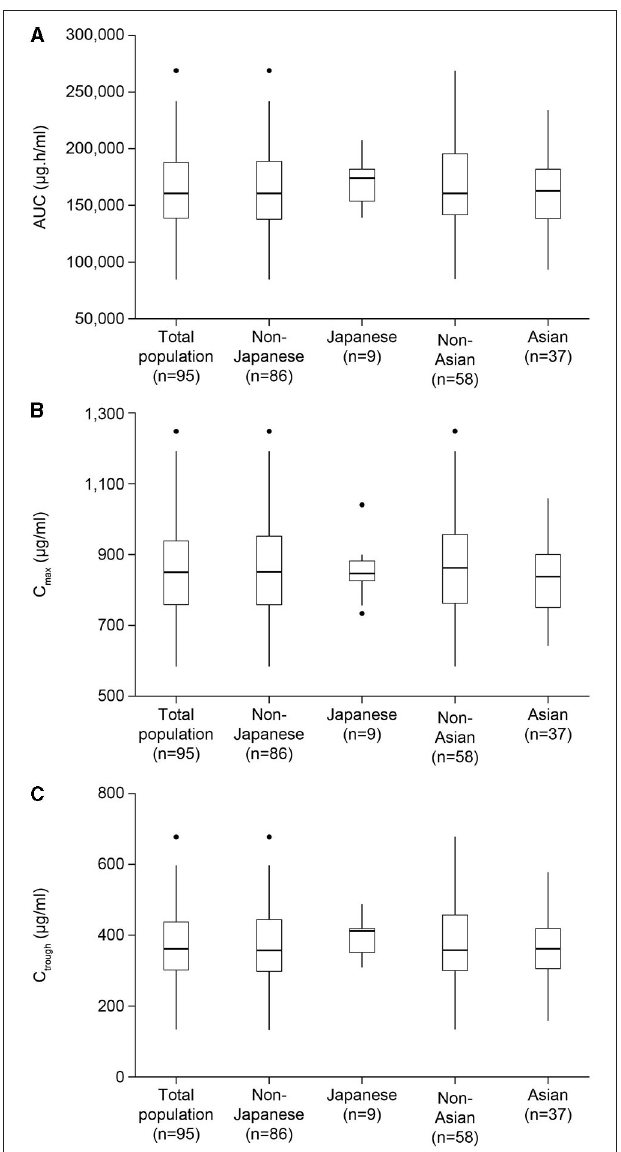
FIGURE 2 | Estimated body weight-normalized eculizumab exposure parameters for the total patient population, Asian, non-Asian, Japanese, and non-Japanese patients. Results are shown for parameters at steady state: (A) AUC, (B) C max , and (C) C trough . Exposures were normalized by body weight using the exponent estimated in the final model. AUC, area under the concentration–time curve within one dosing interval; C max , peak concentration; C trough , concentration at the end of the dosage interval; ss, steady